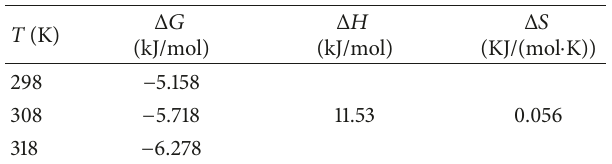
Table 2: The adsorption thermodynamic parameters of Sb(III) using Fe 3 O 4 /GO.